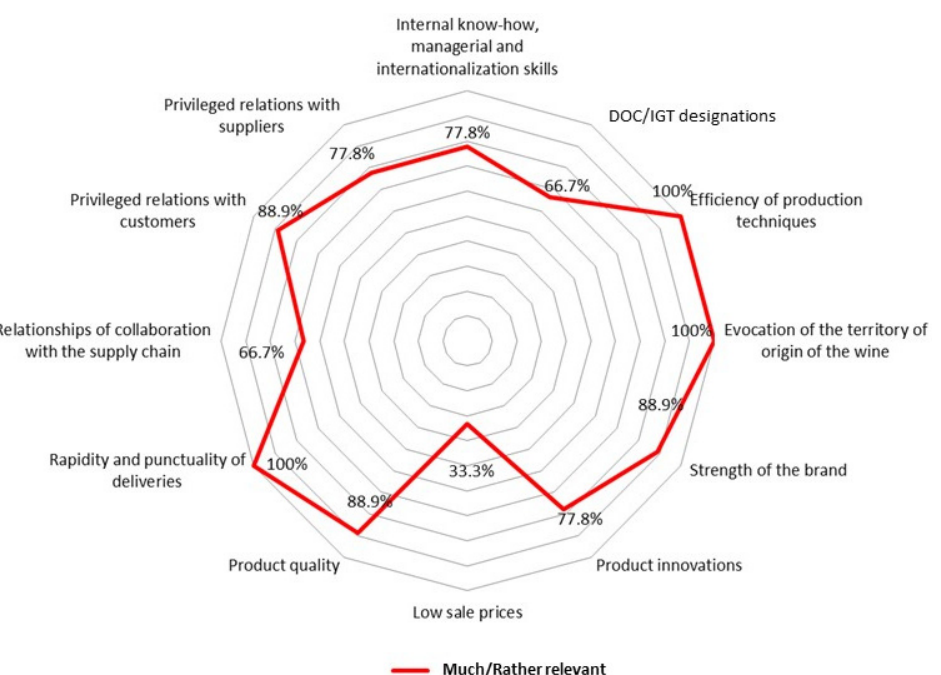
Figure 2. Percentage of importance/relevance given by the panelists for the 12 outcomes for enhanc- ing the value of the link between Etna Rosso DOC wine and the territory.